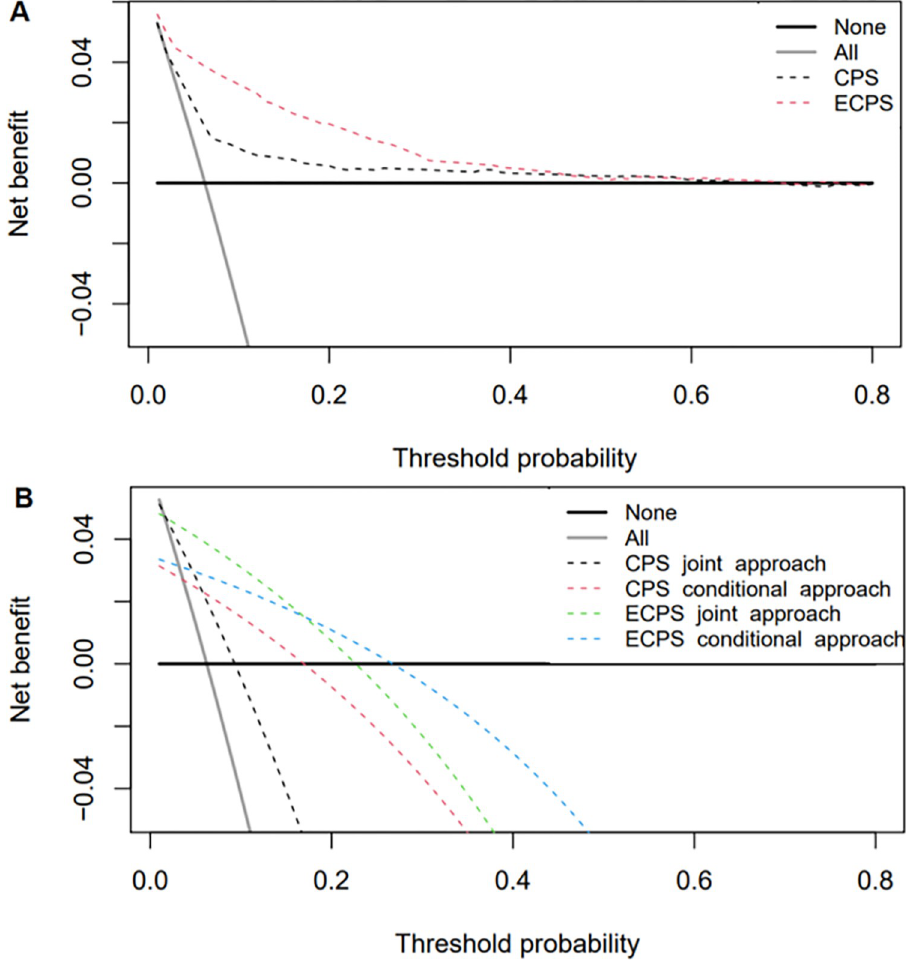
Fig 6. The decision curve plotting the net benefit of the prediction scores at a range of threshold probability. (A) represents the DCAs for the CPS and ECPS, and (B) the DCAs for the joint and conditional approaches with CPS and